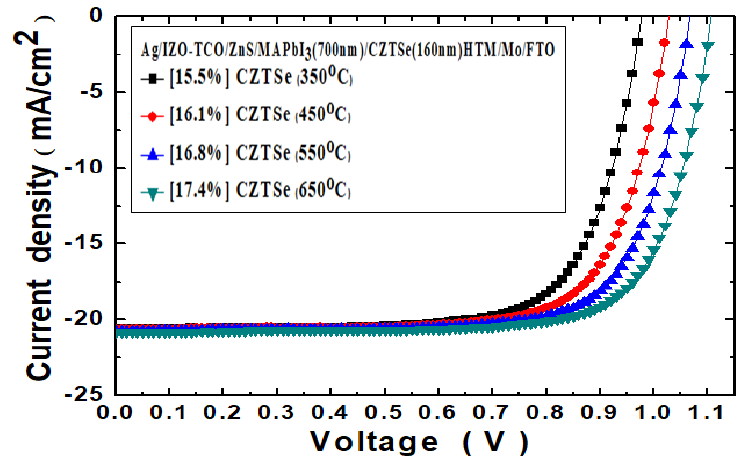
Figure 10. The J – V curves of Ag/IZO/ZnS/MAPbI 3 /Cu 2 ZnSnSe 4 /Mo/FTO nanostructured solar cells, under 100 mW/cm 2 illumination. The IZO layer thickness has been 100 nm. Table 3. The PV characteristic parameters of the Ag/IZO/ZnS/MAPbI 3 /Cu 2 ZnSnSe 4 /Mo/FTO nanostructured solar cells.